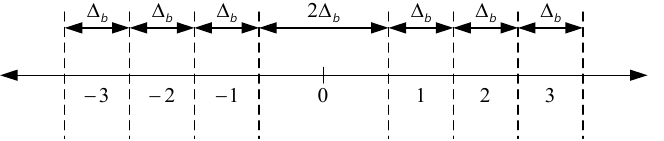
Figure 8. Illustration of the quantization process with uniform scalar quantizer with dead ‐ zone.